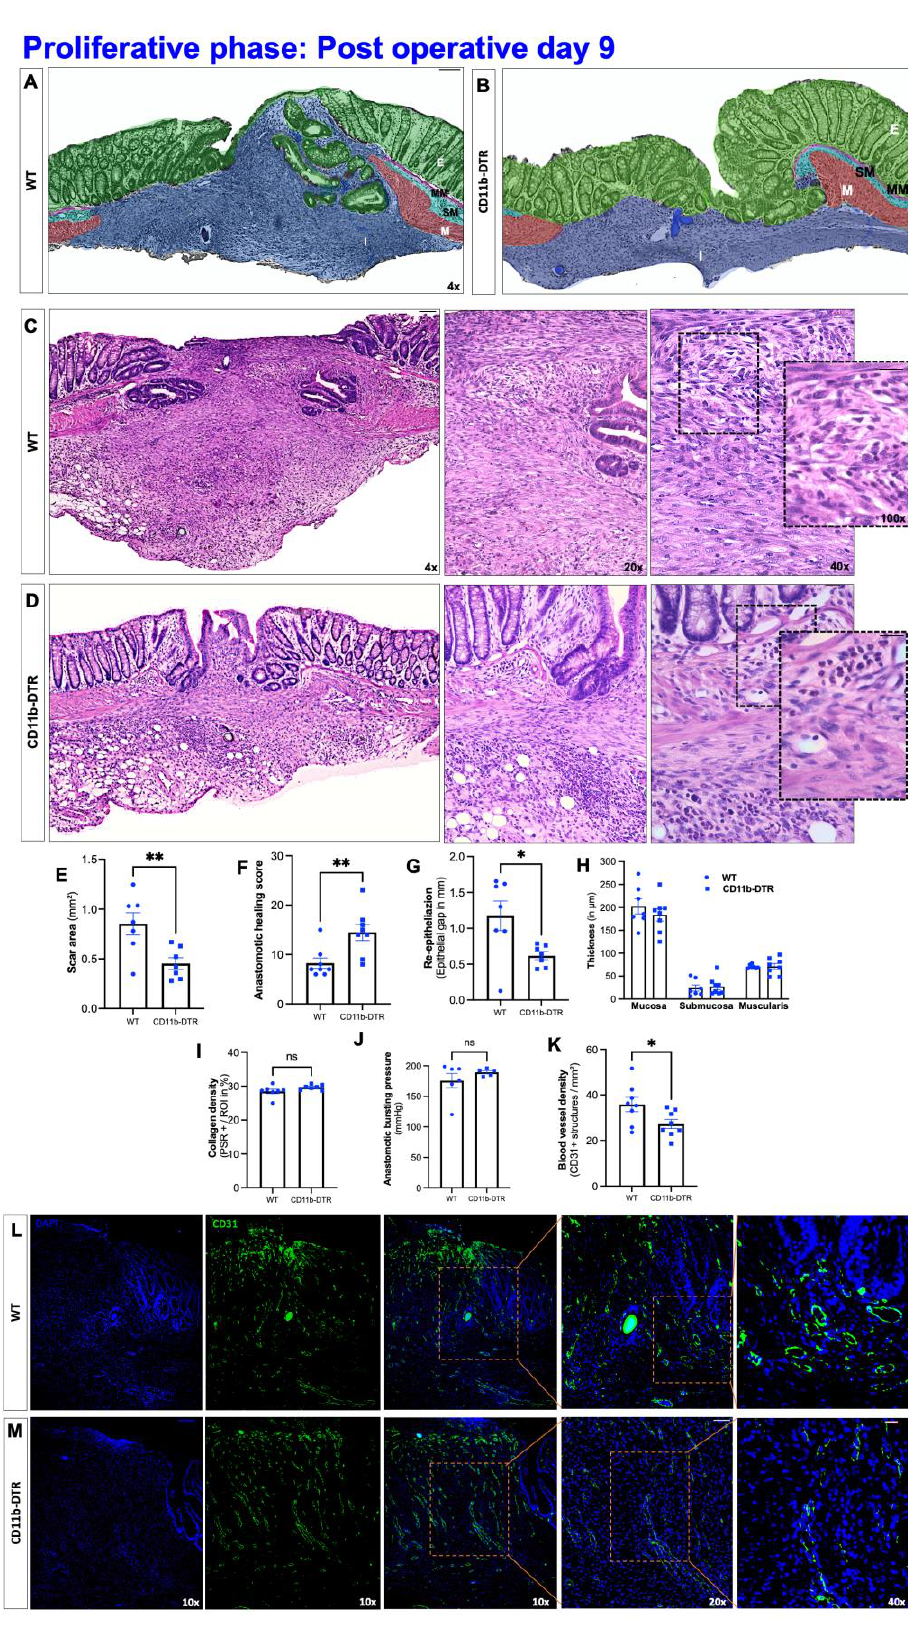
Figure 6. Intestinal anastomotic healing during the proliferative phase. Multicolor stained sections of anastomotic healing (AH) at postoperative day 9 in ( A ) wild type (WT) and ( B ) CD11b-diphtheria toxin receptor (DTR) mice. E = epithelium (green); MM = muscularis mucosae (purple); SM =